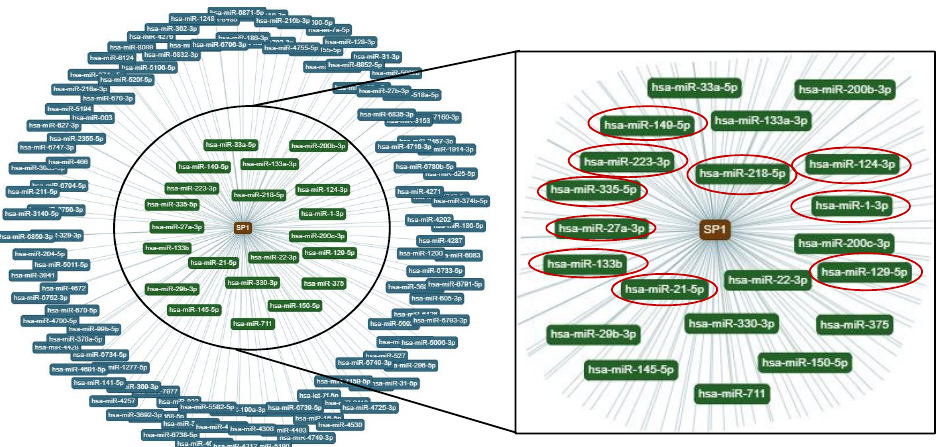
Figure 7. The miRNAs that target Sp1 were analyzed by the bioinformatics tool miRTargetLink Human. The central node represents Sp1, surrounded by the miRNAs that target Sp1 with strong ( green ) and weak ( blue ) evidence. Red circles indicated miRNAs that target Sp1 and that were identified in